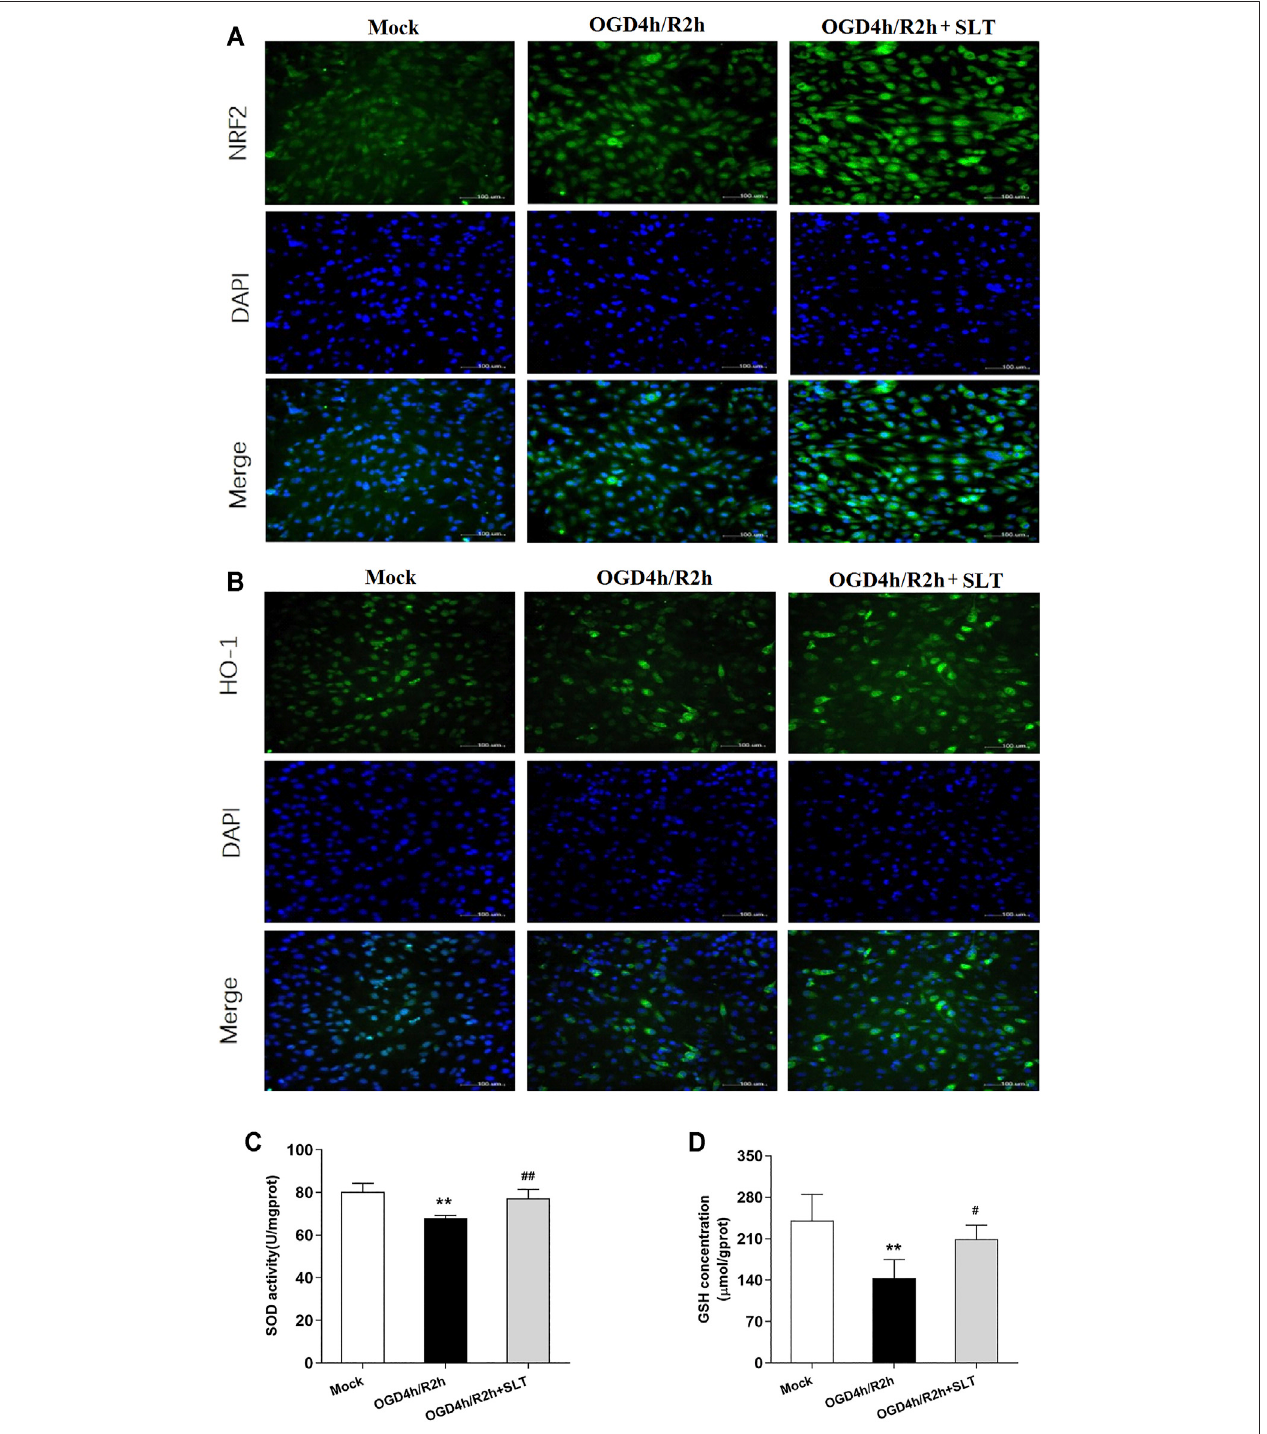
FIGURE5| SLTactivated Nrf2pathway inOGD/R-injured hCMEC/D3cells. (A,B) Imagesofcytoimmuno fl uorescent examination ofNrf2andHO-1 expressions in cells undergoing OGD/R injury (scale bar (cid:1) 100 μ m). (C,D) SOD activities and GSH contents in hCMEC/D3 cells undergoing OGD/R injury ( n (cid:1) 5 each). Data are expressed as mean ± SD. * p < 0.05, ** p < 0.01, vs. the mock group; # p < 0.05, ## p < 0.01 vs. the OGD/R group.